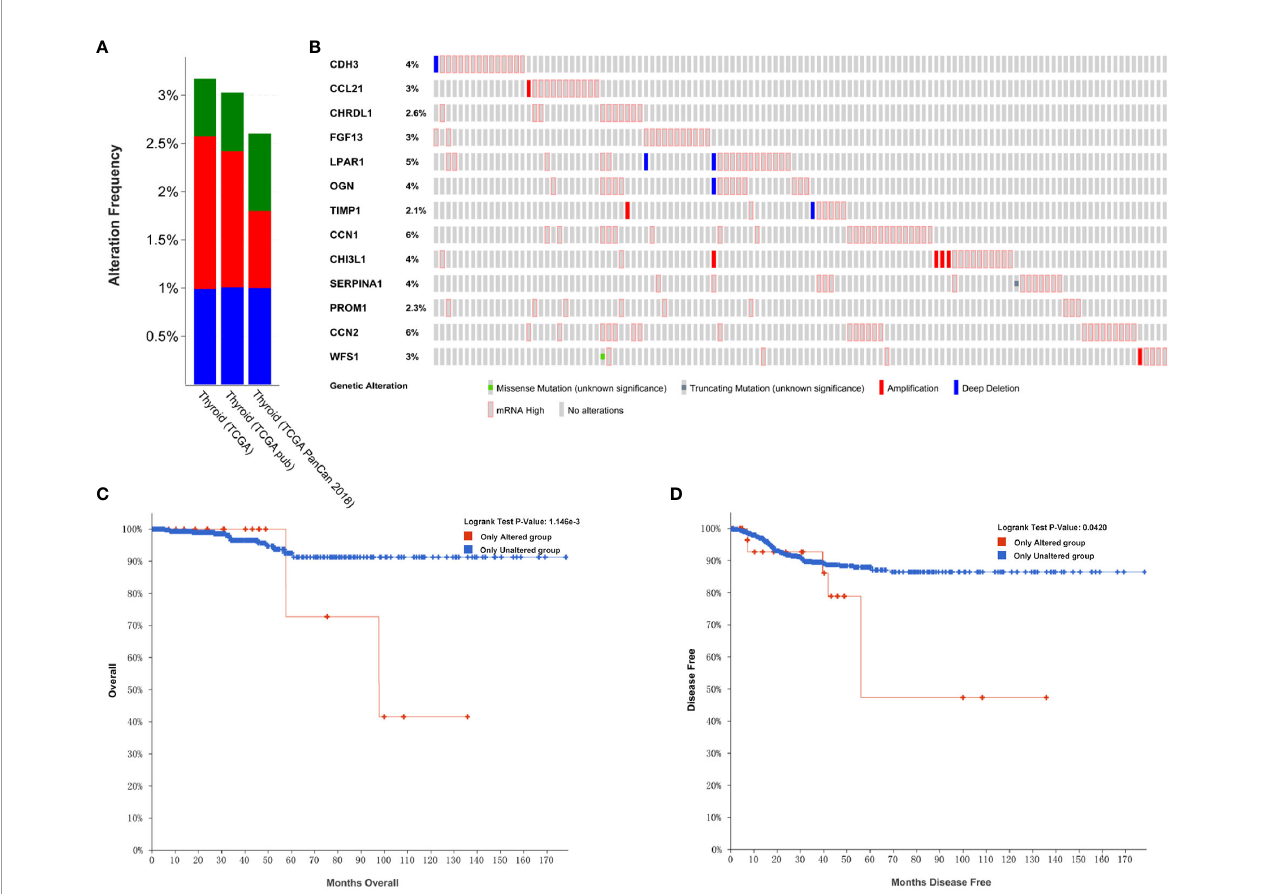
FIGURE 7 | Genetic alterations linked to hub genes in THCA in the TCGA. (A) Thirteen hub gene alterations in THCA (TCGA, Firehose Legacy), PTC (TCGA, Cell 2014), THCA (TCGA, PanCancer Atlas). (B) Alteration frequencies of hub genes based on the PTC (TCGA, Cell 2014) dataset. (C) Kaplan-Meier plots comparing OS in cases with and without hub gene alterations. (D) Kaplan-Meier plots comparing DFS in cases with and without hub gene